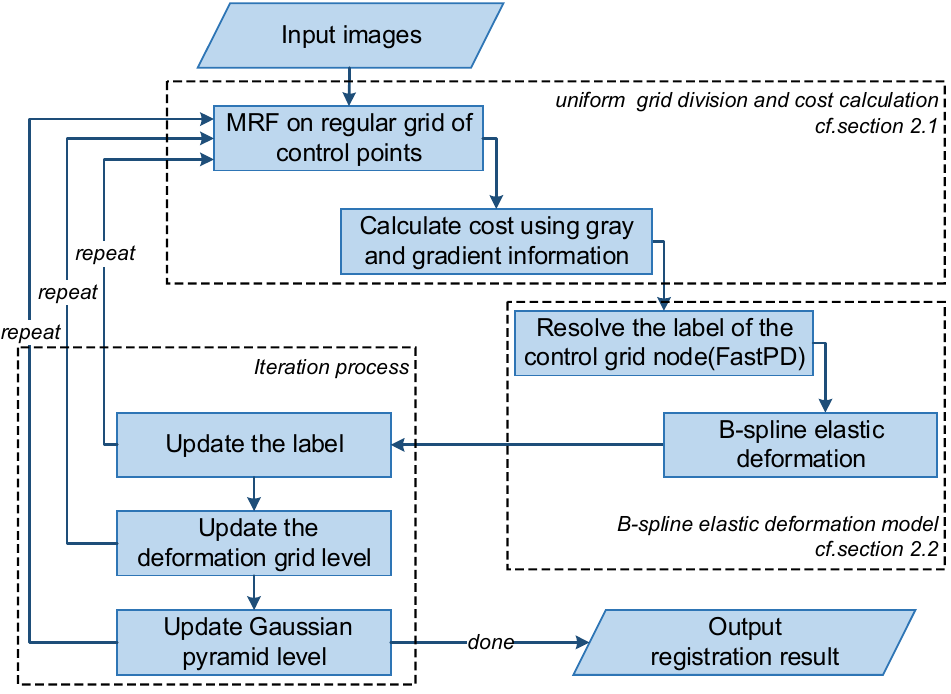
Figure 2. Overview of presented approach for multimodal image registration.